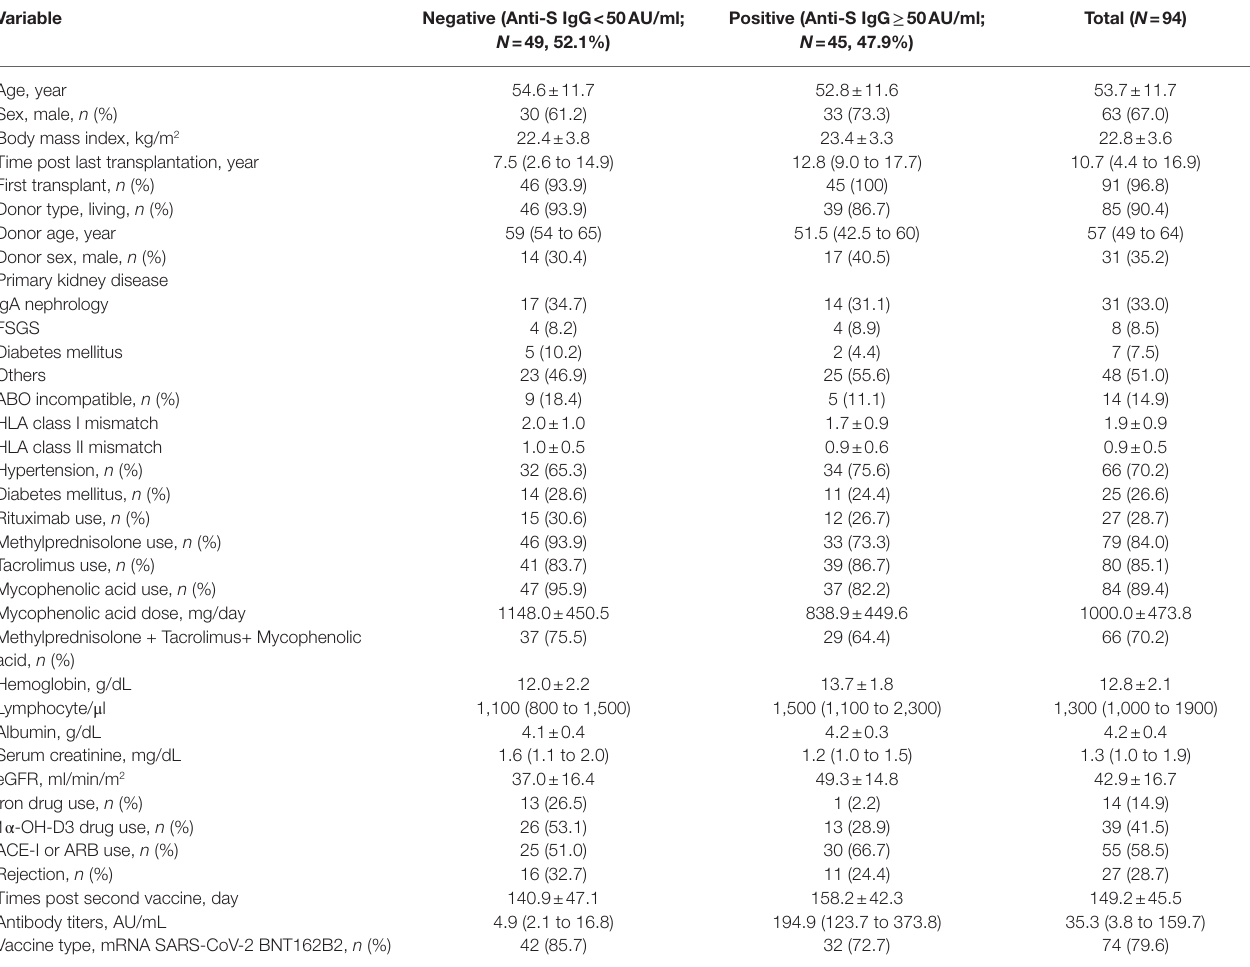
FSGS, Focal segmental glomerulosclerosis; ACE-I, angiotensin-converting enzyme inhibitor; ARB, angiotensin II receptor blocker. Values are n (%) or presented as means ± standard deviation or medians (interquartile range, 25th–75th